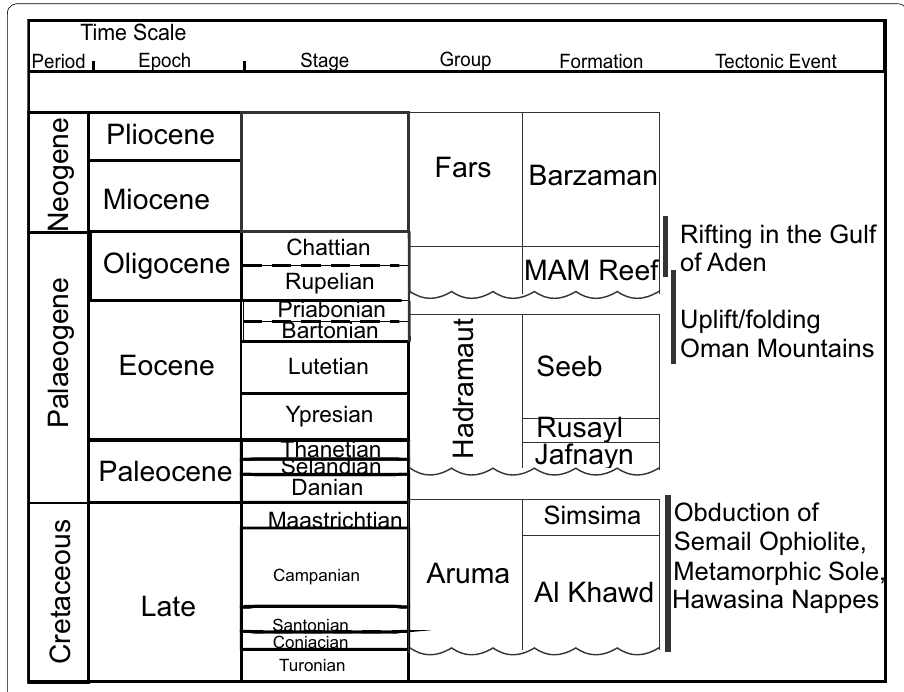
Fig. 3 Stratigraphic chart showing the units in the study area from late Cretaceous to Pliocene time [modified from Al-Lazki et al. (2002), Breton et al. (2004), Al-Husseini